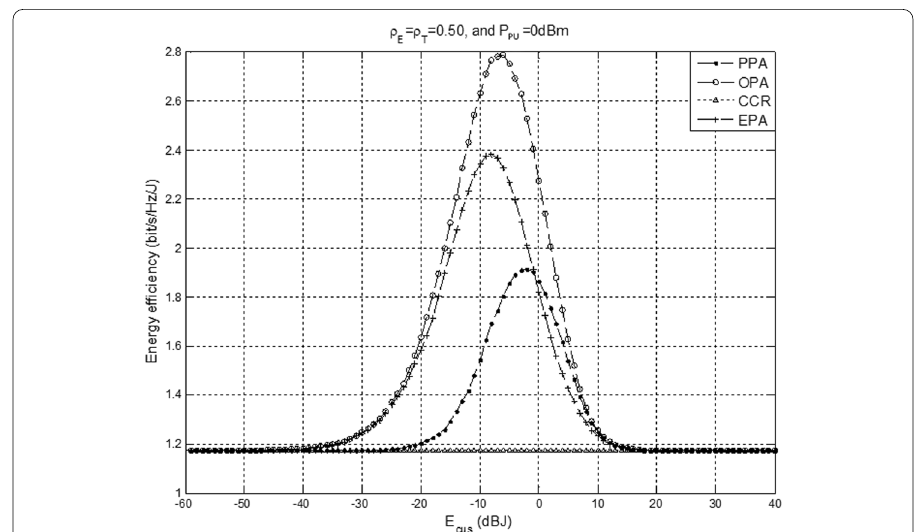
Fig. 7 Energy efficiency for different algorithms as a function of E